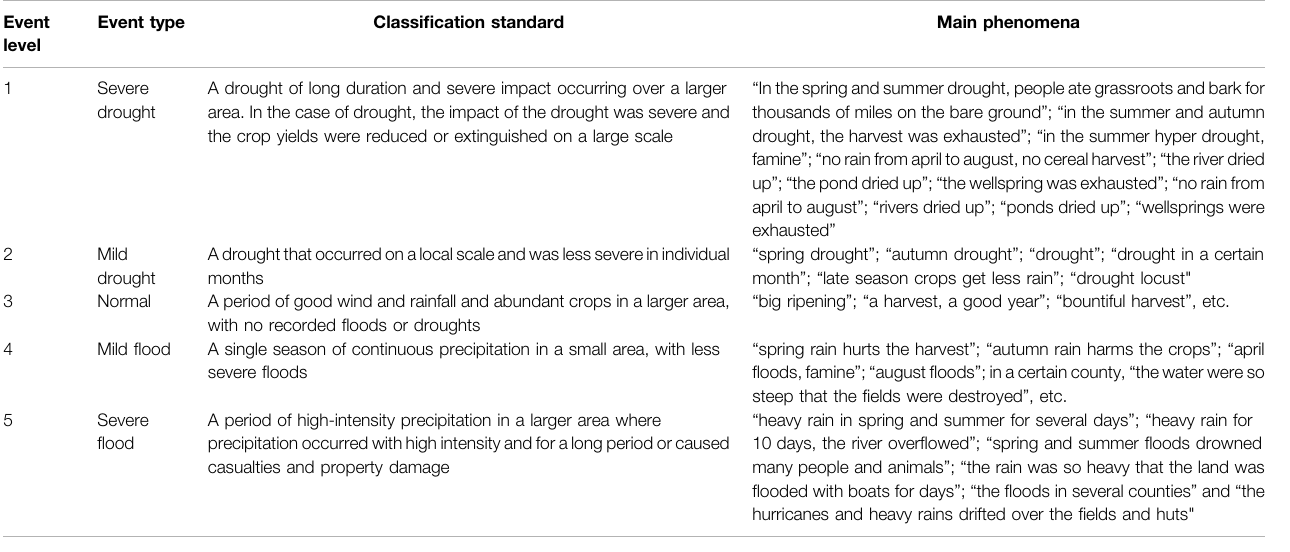
TABLE 1 | Classi fi cation standards of drought and fl ood events.